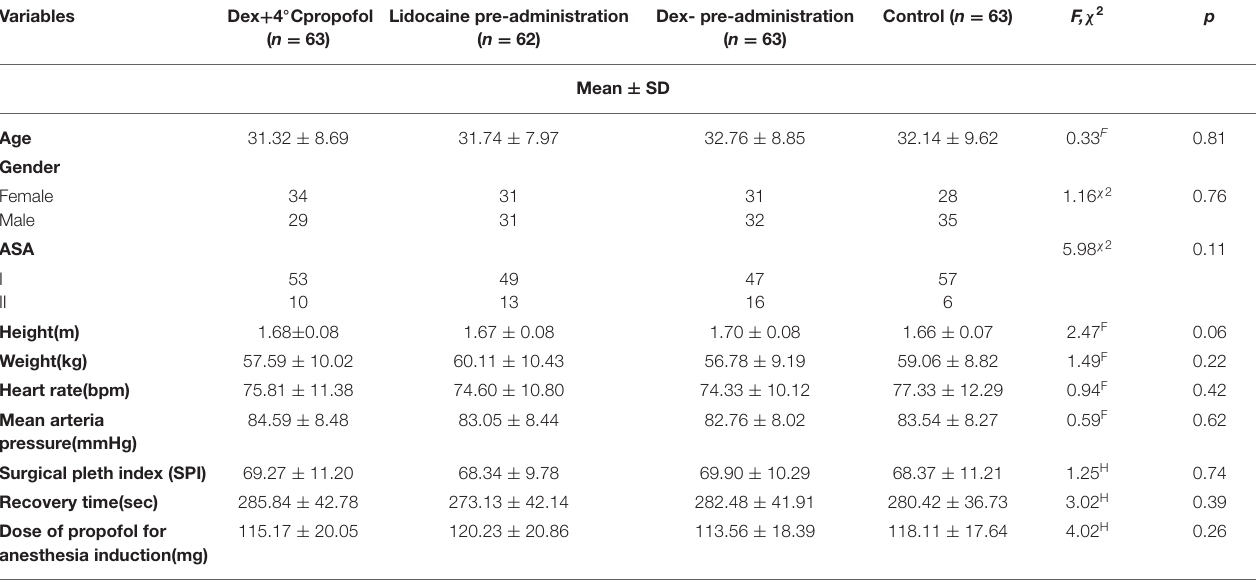
TABLE 1 | Baseline characteristics of included patients ( n =